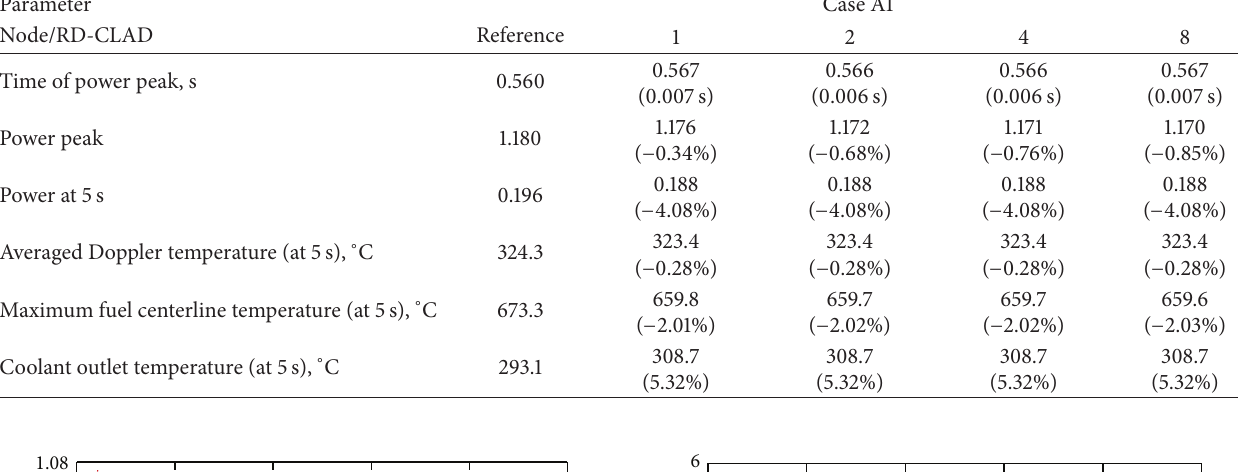
Table 12: Sensitivity analysis results in the number of nodes for the fuel cladding heat conduction calculation for case A1.